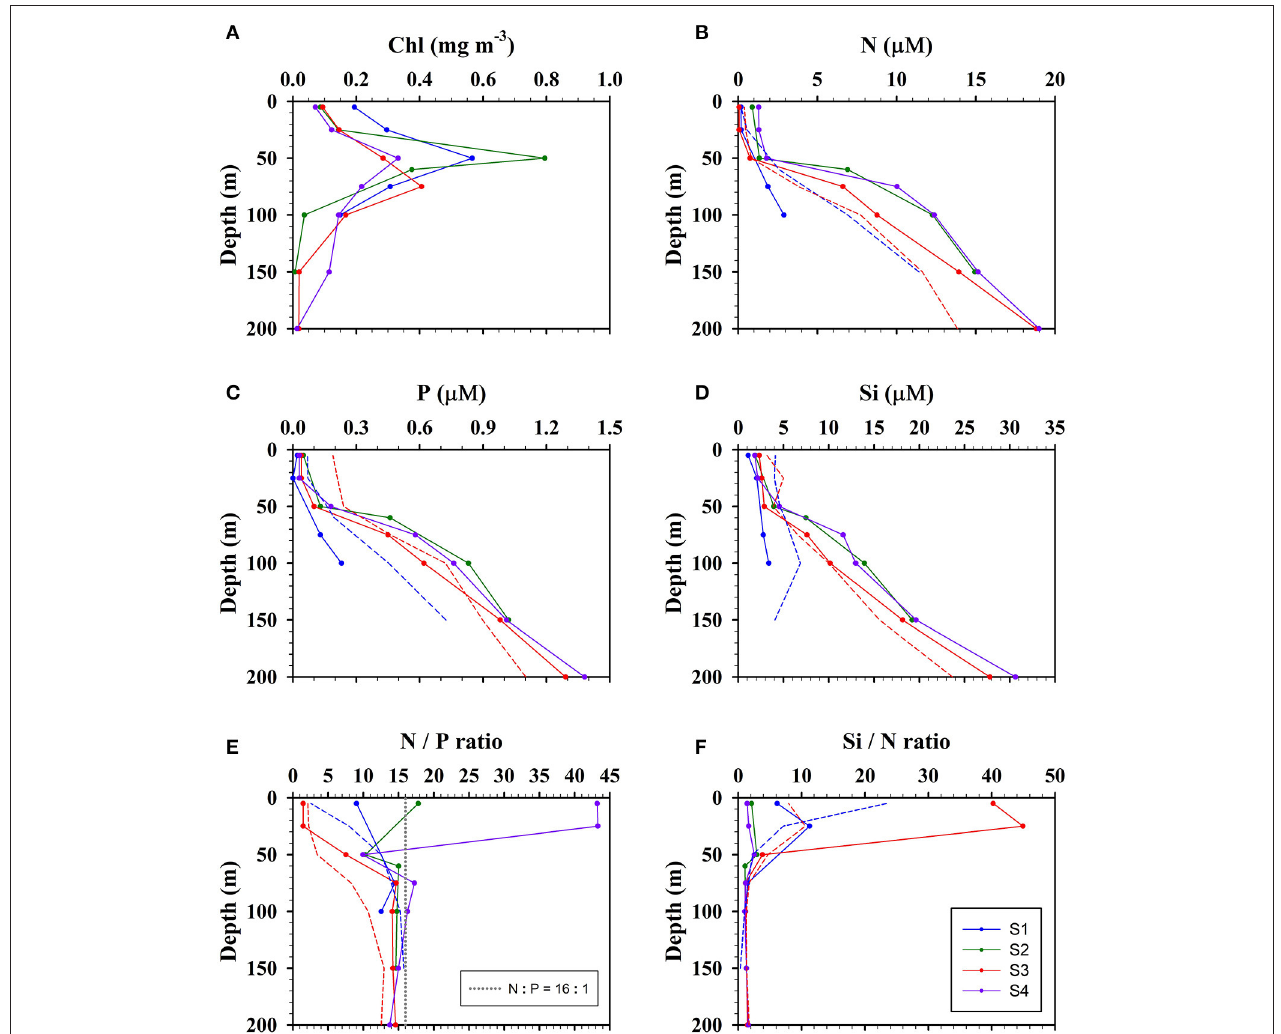
FIGURE 6 | The concentration profiles of (A) chlorophyll-a (Chl), (B) nitrate + nitrite (N), (C) phosphate (P), (D) silicate (Si), (E) N:P ratio and (F) Si:N ratio, observed at Stations S1 (blue) and S2 (green) from April 14 to 17, 2013 and at Stations S3 (red) and S4 (purple) from May 20 to 28, 2014. Blue and red dashed curves show the relative climatological profiles for April and May, respectively, obtained from